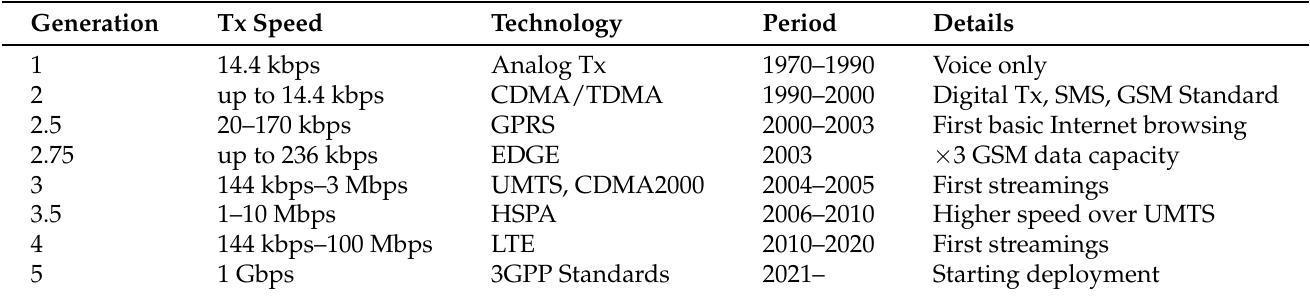
Table 1. Mobile networks history in